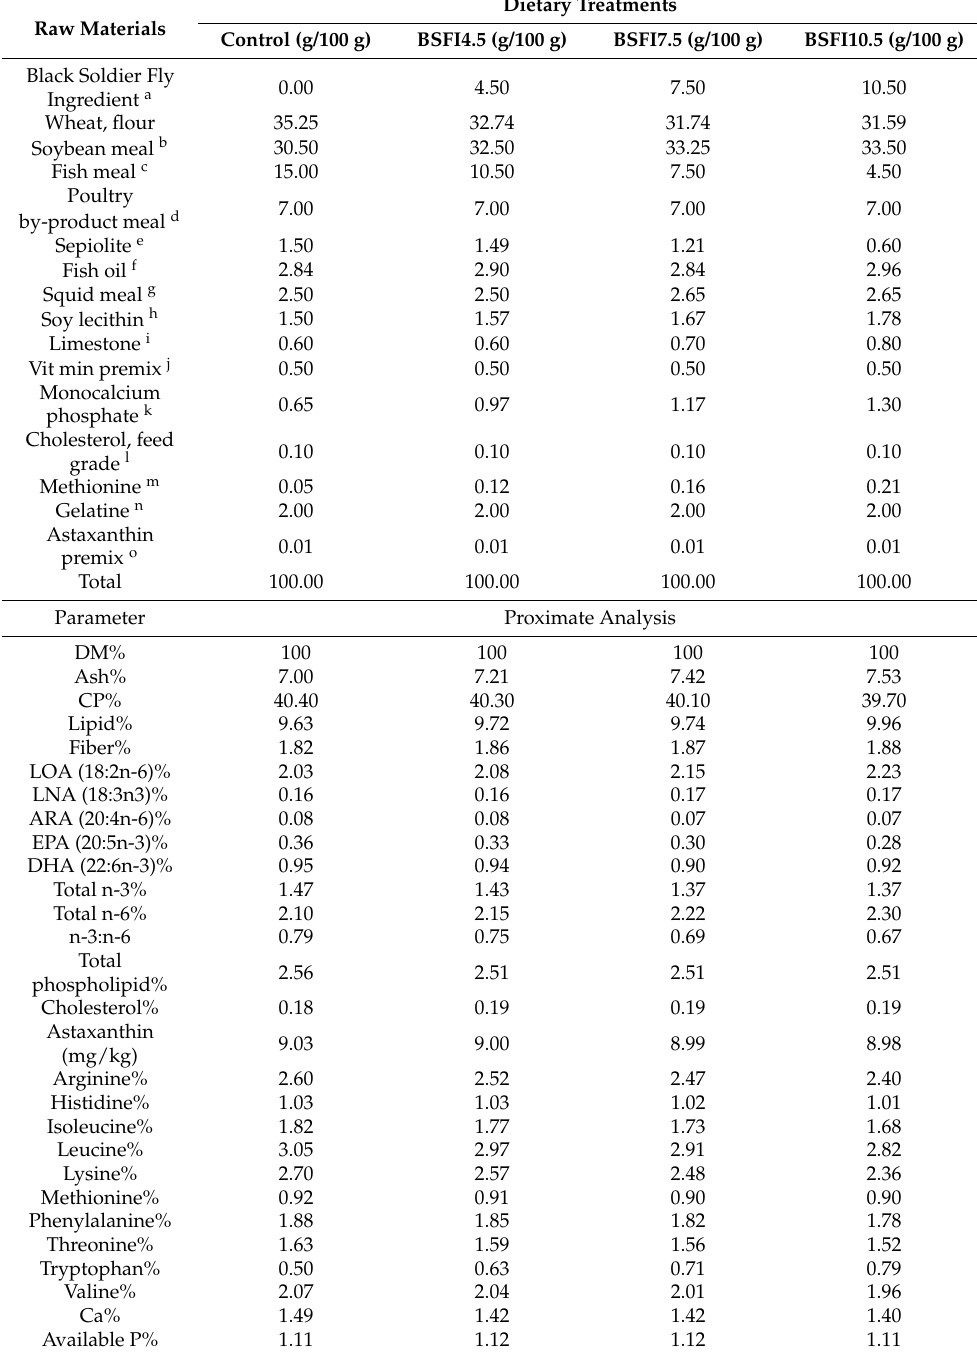
Table 1. Formulation and proximate composition of the experimental diets (Control, and test diets introducing 4.5, 7.5, or 10.5% of BSFI respectively–BSFI4.5, BSFI7.5, and